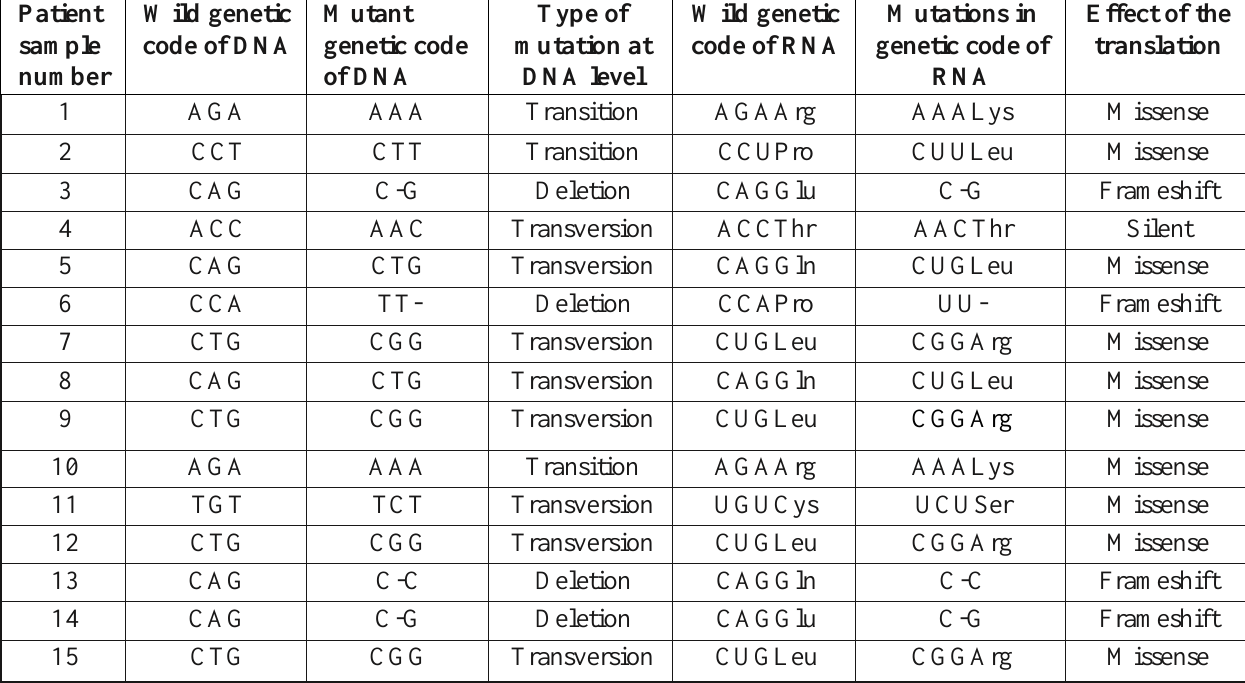
Figure 3 : Show the chromatogram for the forward sequence of amplified the IL-17AR primer for a patient with breast cancer by DNA sequencer Table 3: The wild and mutant genetic code of DNA, type of mutation, and the effect of mutation on the translation process in some patients’ proteins with breast cancer in rs2275913 of